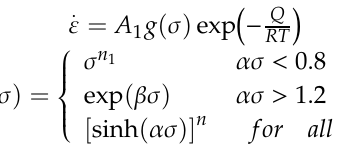
Figure 3. True stress-strain relationship curves of Q345 steel: ( a ) ε  = 0.01 s − 1 ; ( b ) ε  = 0.1 s − 1 ; ( c ) ε  = Figure3. Truestress-strainrelationshipcurvesofQ345steel: ( a ) . ε = 1.0 s − 1 ; ( d ) ε  = 10 s − 1 . ( d ) 10 s − 1